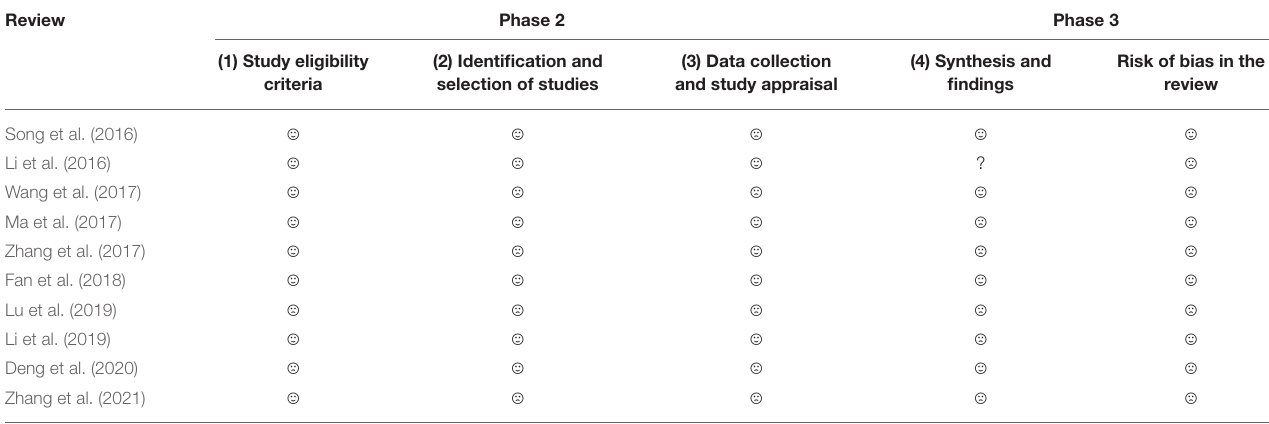
TABLE 4 | Tabular presentation for ROBIS